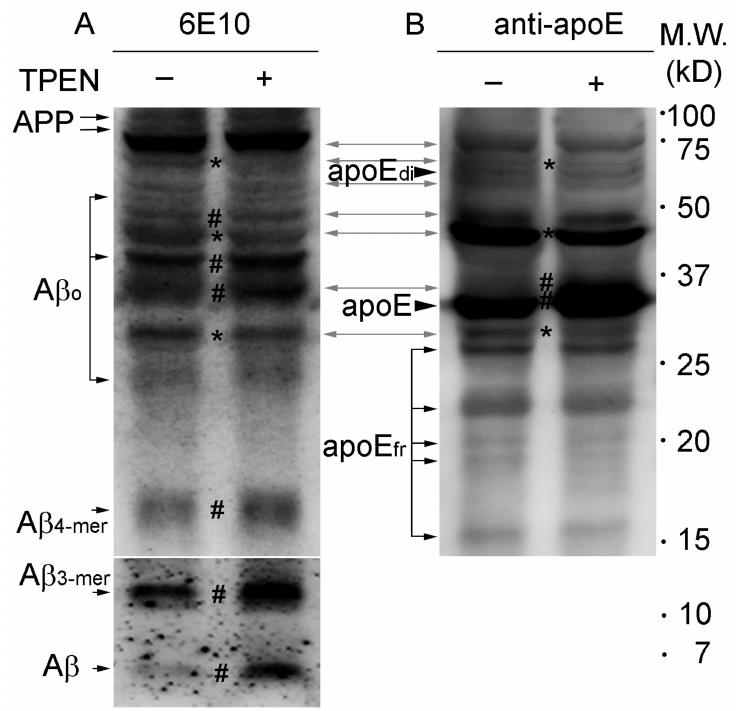
Figure 3. Western blot analyses of A β and apoE in whole brain lysates from Tg2576 mice. Protein lysates were prepared with (right lanes) or without (left lanes) 100 µ M TPEN, separated on a Tris-Tricine gel, and the transferred blots were incubated with antibody against A β (6E10) ( A ) or apoE ( B ). The bidirectional grey arrows represent apoE / A β complexes. Asterisks (*) and number signs (#) on blots indicate reduction and increase in band density of proteins by TPEN treatment, respectively.